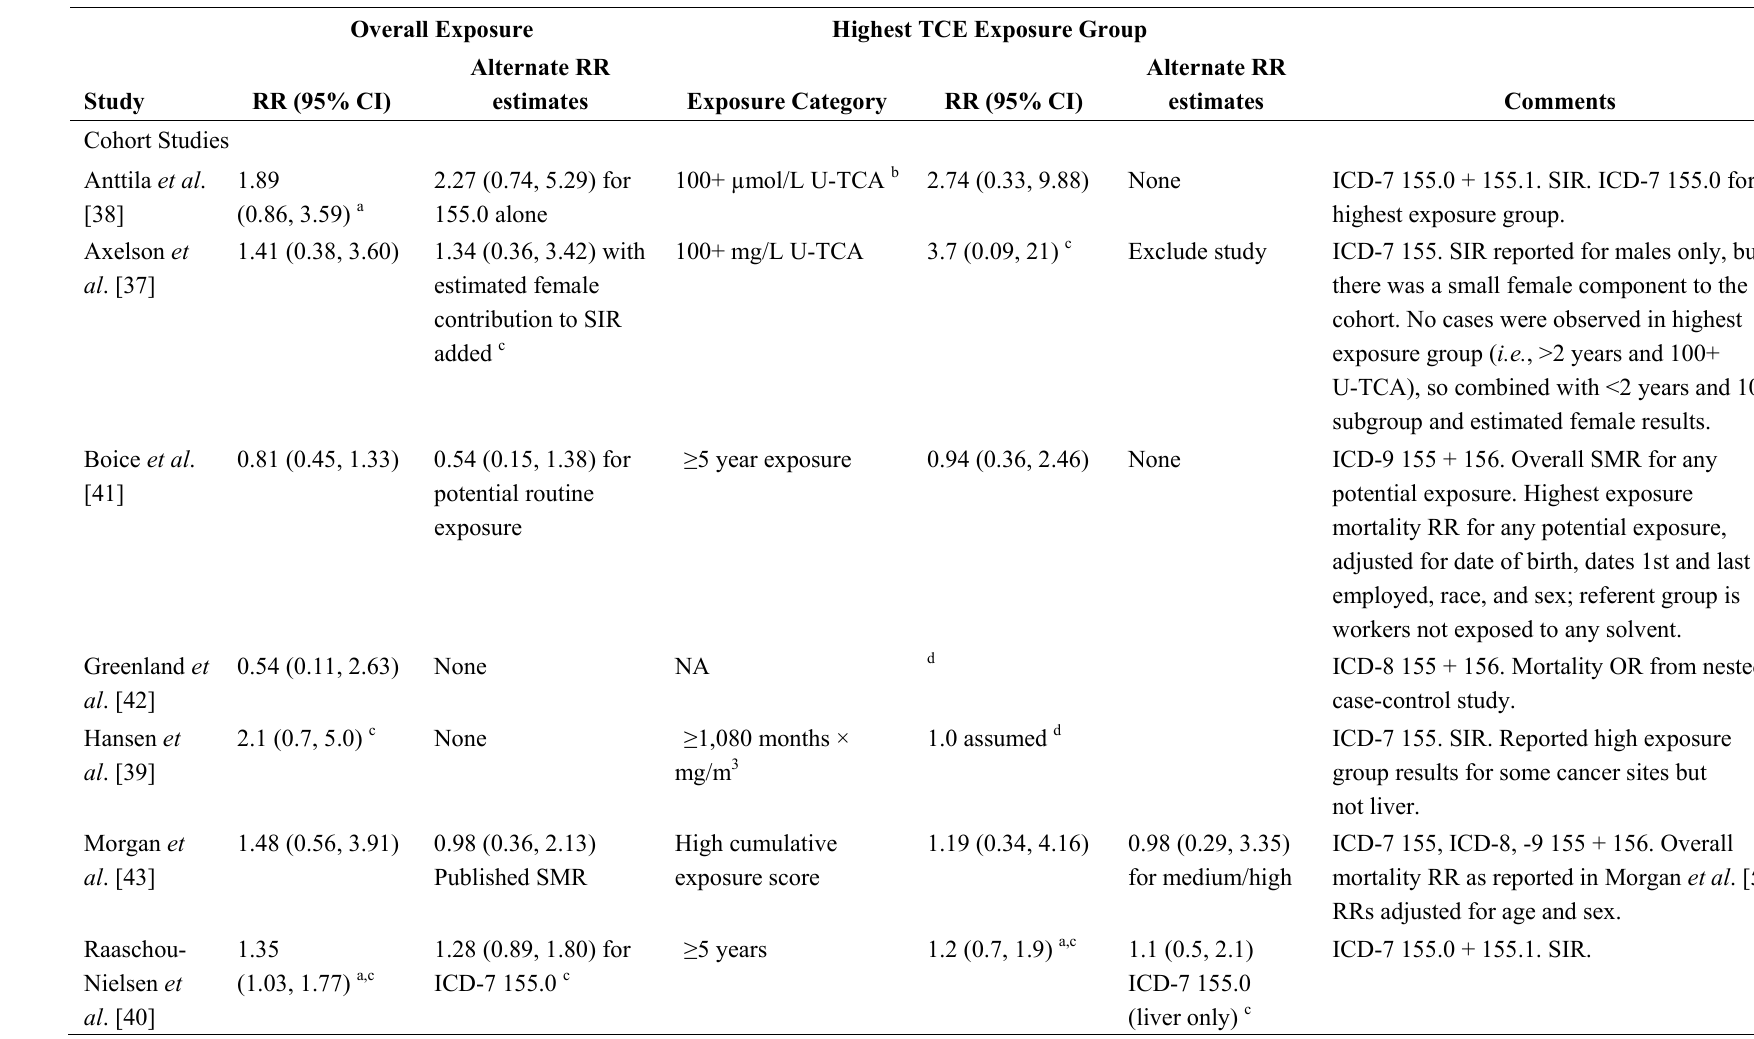
Table 3. Selected RR estimates for liver cancer associated with TCE exposure (overall and highest exposure group) from cohort and case-control